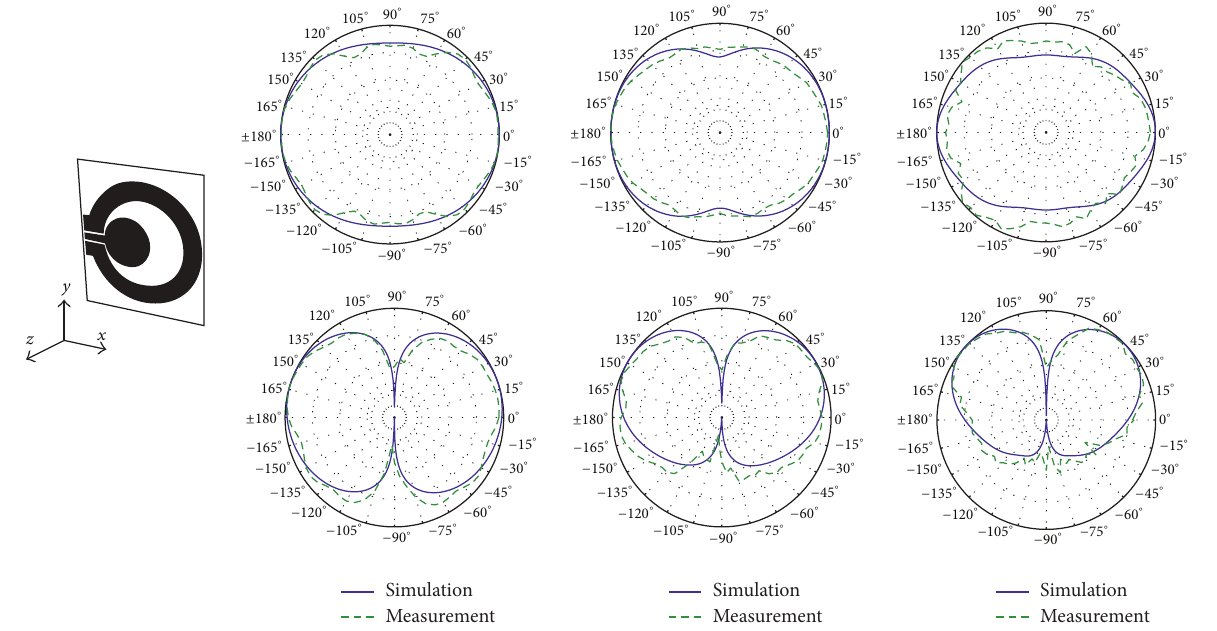
Figure 12: Radiation patterns of the antenna at frequencies 4 GHz, 6 GHz, and 10GHz. First column: 𝑦𝑧 plane for 𝑥 = 0 , second column: 𝑥𝑧 plane for 𝑦 = 0 . Simulation: solid line. Measurement: dashed line.